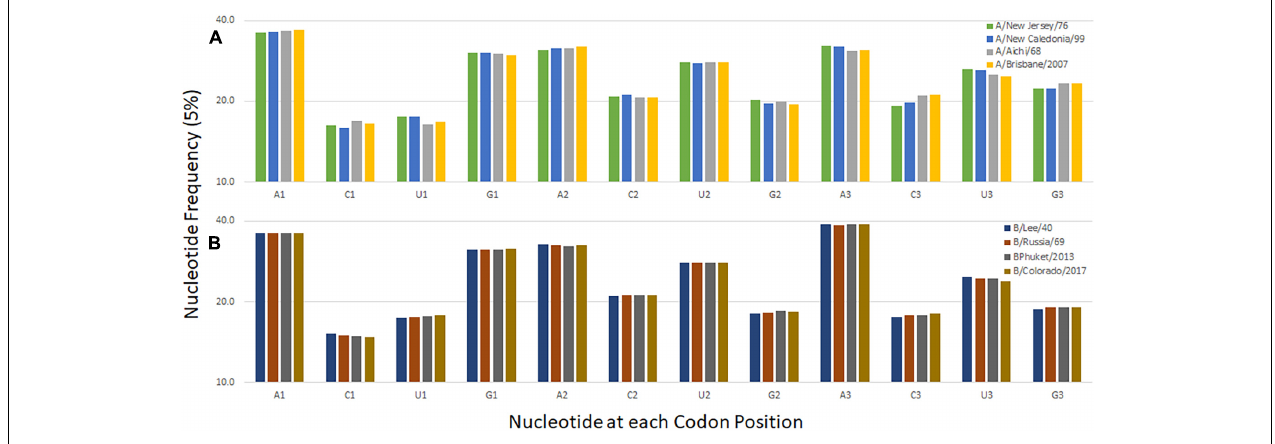
FIGURE 2 | Codon nucleotide composition for influenza A (A) and influenza B (B) viruses. The frequency of each of the four nucleotides at each of the three codon positions is shown.